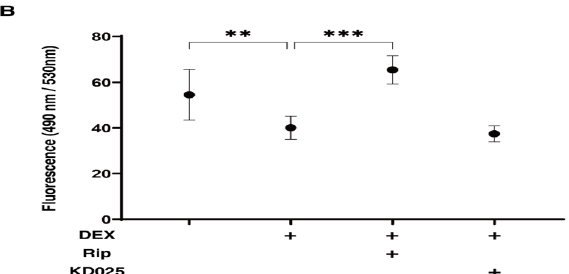
Figure 1. Effects of ROCK-is on transendothelial electrical resistance (TEER) ( A ) and FITC–dextran permeability ( B ) of DEX-treated 2D culture of HTM cell monolayers. In the presence of 10 µM ripasudil (Rip) or KD025, the barrier function ( Ω cm 2 ) and permeability of DEX (250 nM) untreated or treated 2D-cultured HTM monolayers, TEER ( A ) and FITC–dextran permeability ( B ) were evaluated, respectively. All experiments were performed in triplicate using fresh preparations ( n = 4). Data are presented as the arithmetic mean ± standard error of the mean (SEM). ** p < 0.01, *** p < 0.005 (ANOVA followed by a Tukey’s multiple comparison test).